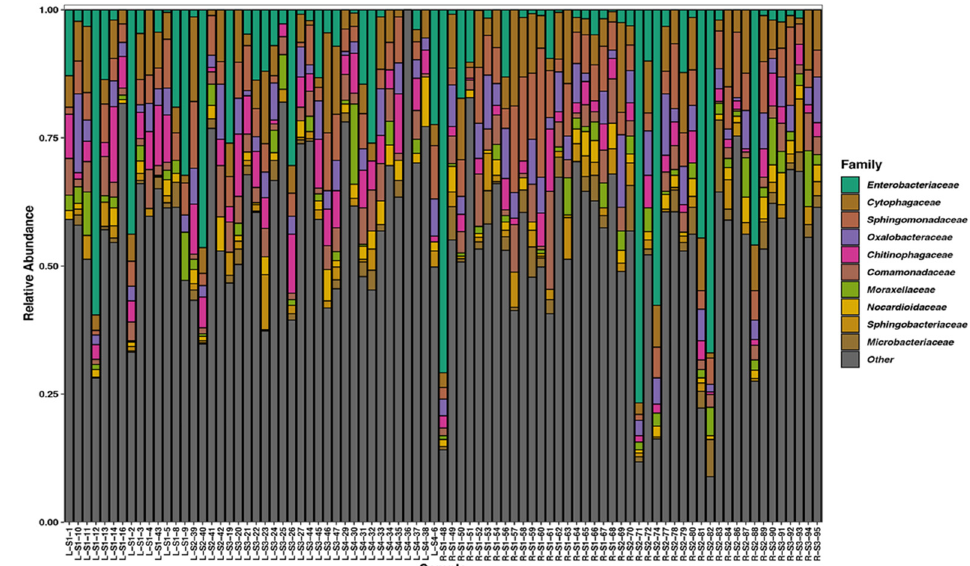
Figure 2. Stacked bar plot of the average relative abundance of the ten most proportionally abundant bacterial families across all samples and all other families combined as “other”. Sample names contain identifying information about species and site: “L” or “R” corresponds to O. lignaria and O. ribifloris respectively, “S#” corresponds to sites 1–4, and the last number is the unique sample number. Bacterial family is denoted by color.